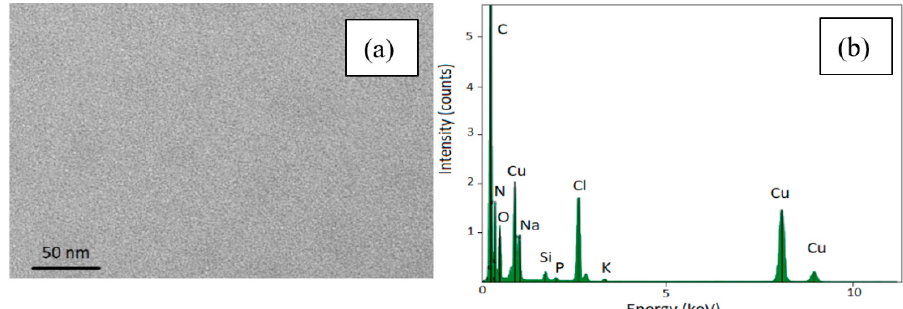
Figure 5. TEM image of the supernatant removed after centrifugation (panel a ) and its EDS spectrum (panel b ).